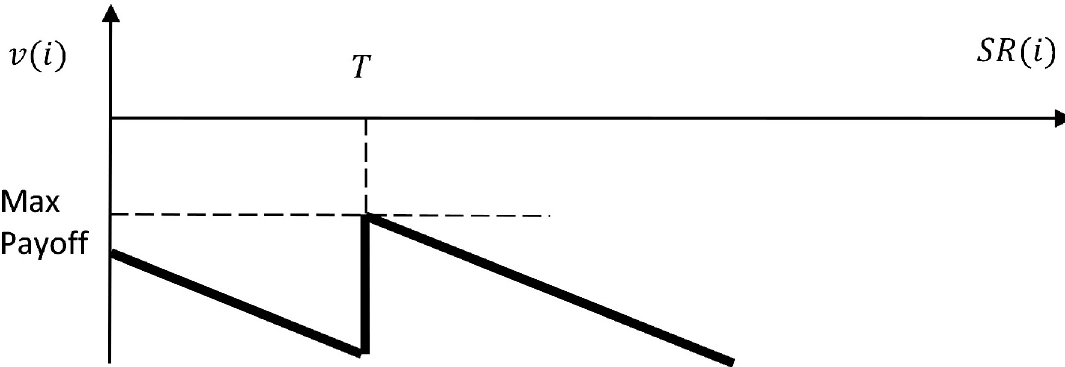
Fig 3. Pay-off function of the agent (country i ). The payoff function v ( i ) of a country i is strictly negative therefore drawn in the second quadrant of the system of coordinates (payoff, number of reports). Costs increase with the number of reports SR ( i ) as long as the country is below the blacklisting threshold T . At the threshold, the costs are minimal (the payoff is maximized). Costs increase directly proportional with the number of reports, when the number of reports exceeds the minimum threshold. Since reporting entities only report false reports in this setting, the slope of the curve is equal to c L